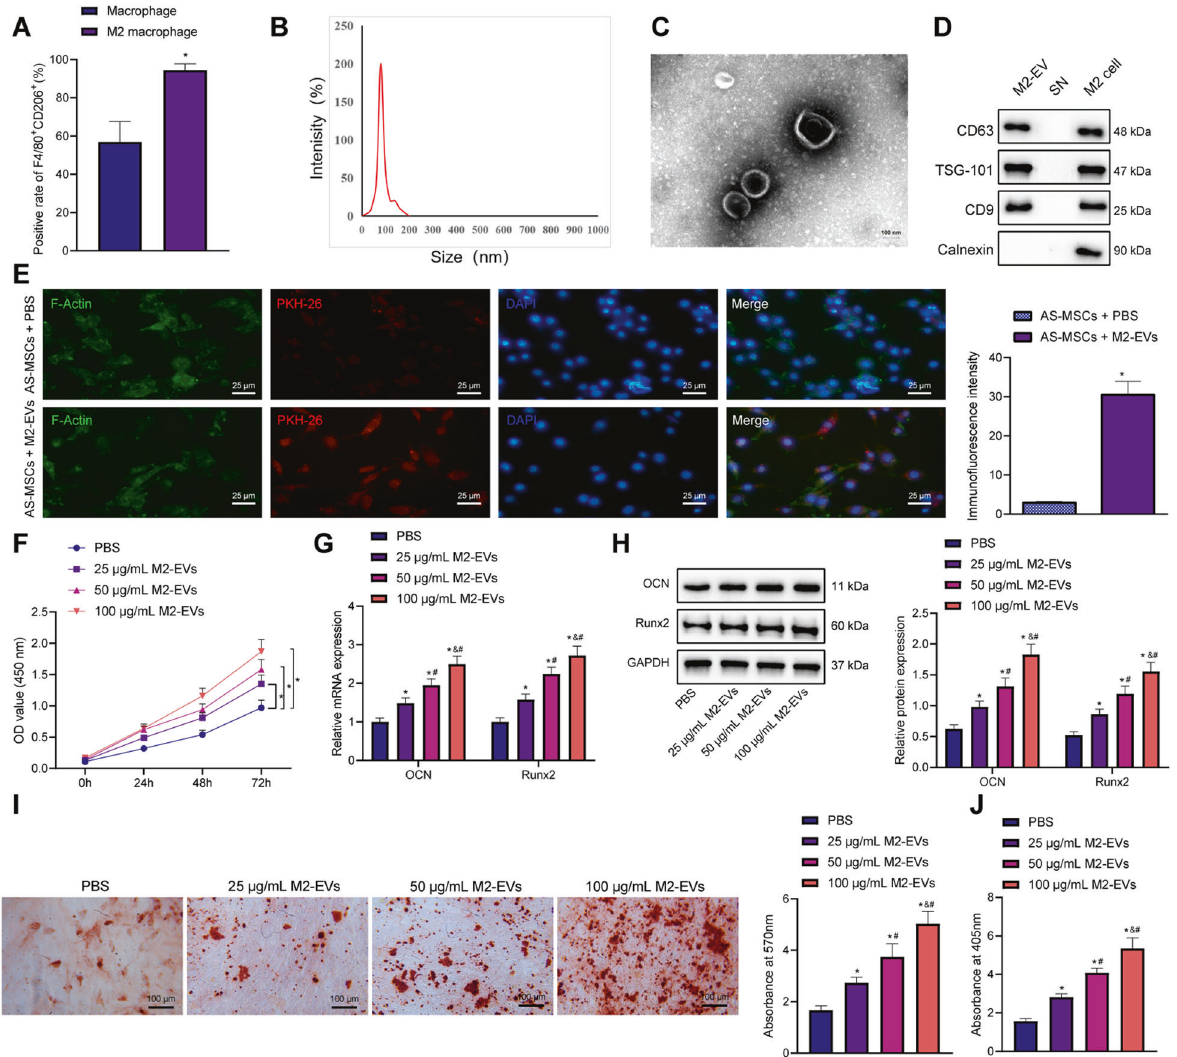
Fig. 1 Effects of M2-EVs on the viability and osteogenic differentiation of AS-BMSCs. A The expression of M2 macrophage markers detected by fl ow cytometry. B The particle size of M2-EVs analyzed by DLS. C Ultrastructure of M2-EVs observed by a TEM (scale bar = 100 nm). D The expression of EV-marker proteins in the M2-EVs measured using Western blot analysis. SN, supernatant. E The uptake of M2-EVs labeled with fl uorescence PKH26 by the AS-BMSCs observed under an immuno fl uorescence microscope (scale bar = 25 μ m). PKH26-labeled EVs were red, DAPI-stained nuclei were blue, and F-actin-labeled cytoskeleton was green. F AS-BMSC viability following coculture with M2-EVs at different concentrations at different time points detected by CCK-8. G The mRNA expression of Runx2 and OCN, osteogenic differentiation markers in AS-BMSCs cocultured with M2-EVs at different concentrations for 7 days, determined by RT-qPCR. H The protein expression of Runx2 and OCN, osteogenic differentiation markers in AS-BMSCs cocultured with M2-EVs at different concentrations for 7 days, determined by Western blot analysis. I The mineralization capacity of AS-BMSCs cocultured with M2-EVs at different concentrations for 14 days detected using alizarin red staining, scale bar = 100 μ m. J Osteogenic differentiation of AS-BMSCs cocultured with M2-EVs at different concentrations for 14 days detected by ALP staining. * p < 0.05 vs. M2 macrophages/AS-BMSCs + PBS. # p < 0.05 vs. AS-BMSCs treated with 25 μ g/mL M2-EVs/ THP-1-EVs /M2-EVs + inhibitor NC, & p < 0.05 vs. AS-BMSCs treated with 50 μ g/mL M2-EVs. The cell experiment was repeated three times